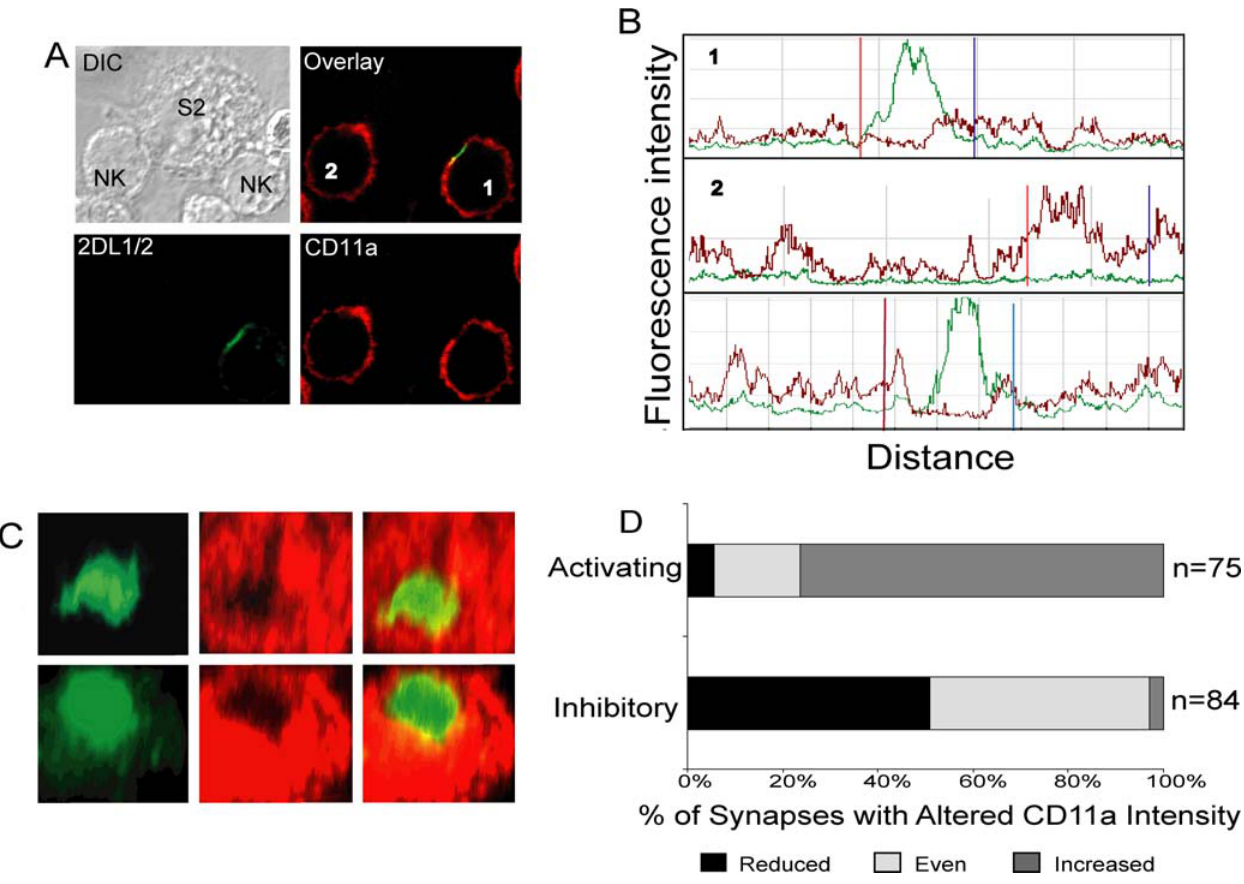
Figure 5. Surface level of CD11a is reduced at inhibitory synapses. IL-2 activated polyclonal human NK cells and S2 cells expressing ICAM-1 and peptide-loaded HLA-Cw4 were mixed at 37 u C for 10 minutes, fixed, permeabilized, and stained with cyt42/43 and a mAb to CD11a followed by the appropriate secondary antibodies. (A) Confocal microscope z -series were obtained, and single sections are shown. The cell labeled # 1, which shows KIR expression and clustering, represents an inhibitory synapse while cell # 2, which lacks KIR2DL1 expression, displays an activating synapse. (B) The fluorescence intensity was scanned around the perimeter of conjugated NK cells. Profiles labeled 1 and 2 are from the corresponding cells in Figure 5A. The third profile is another representative inhibitory synapse. The green and red lines represent the cyt42/43 and anti–CD11a fluorescence, respectively. Vertical red and blue lines mark the boundaries of cell contact as determined in DIC images. (C) Confocal z -stacks were used to create an en face view of the zone of cell contact in 2 inhibitory synapses. (D) The frequency of synapses displaying increased CD11a, reduced CD11a, or no change in CD11a intensity was determined for both activating and inhibitory synapses.